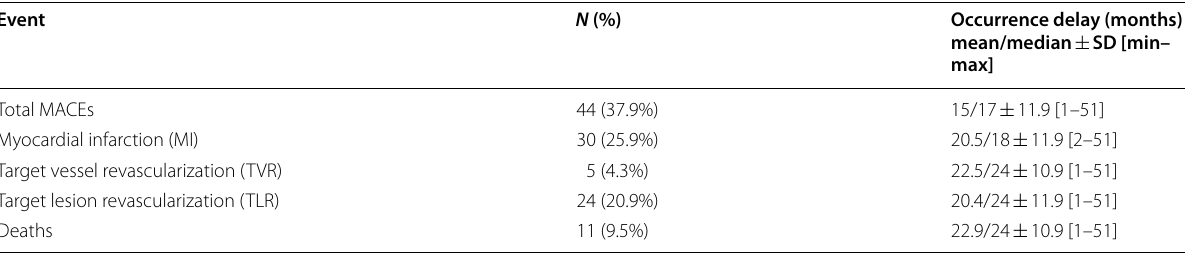
MACEs major adverse cardiac events, max maximum months, min minimum months, SD standard deviation